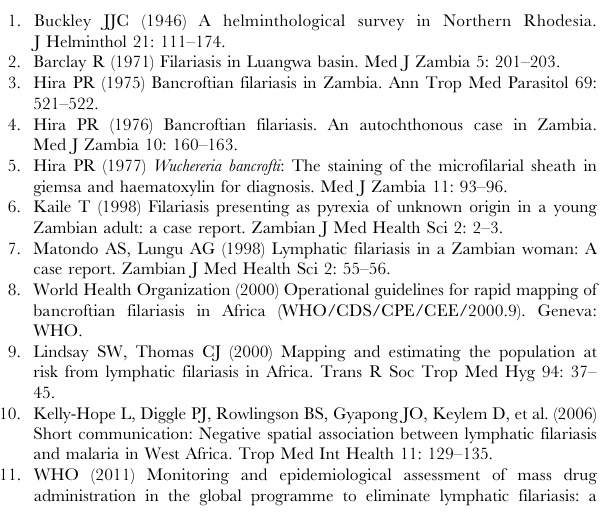
Figure S1 Spatial distribution of a selection of environ- mental predictors in Zambia. The climatic factors were summarized over the survey period and according to climatic seasons in Zambia (NDVI; Normalized Difference Vegetation Index, LST; Land Surface Temperature. HII; Human Influence